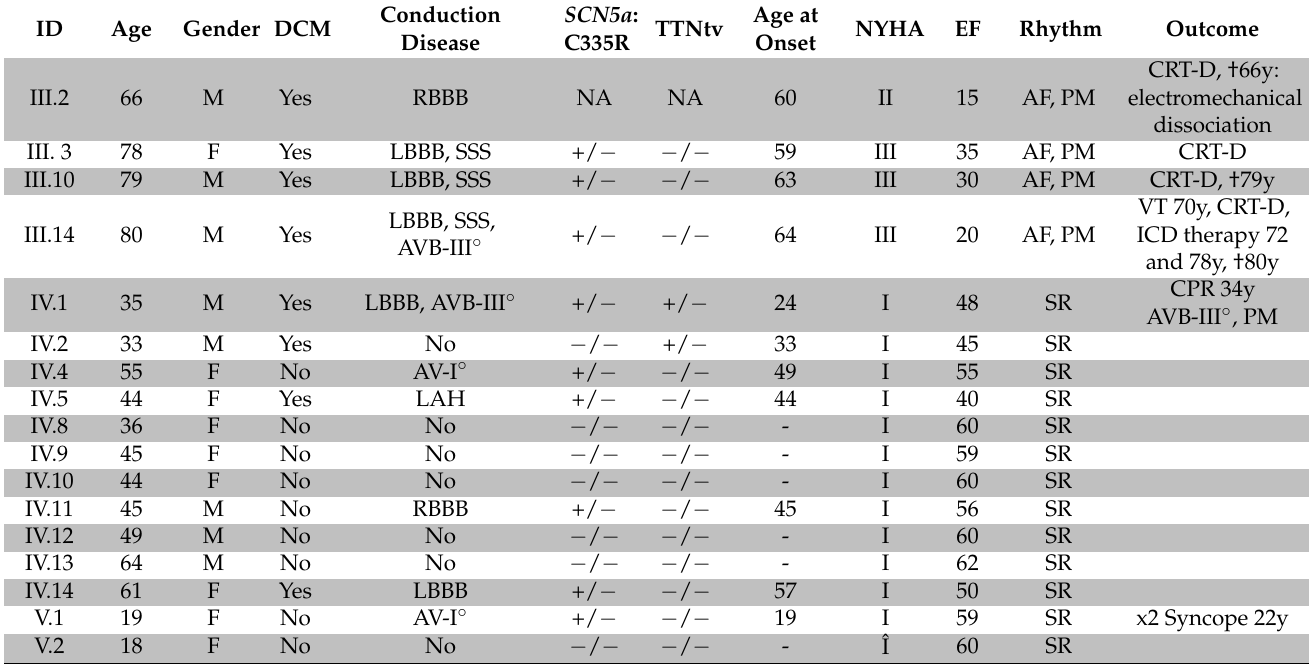
Table 1. Patient characteristics of the family with SCN5a p. C335R variant